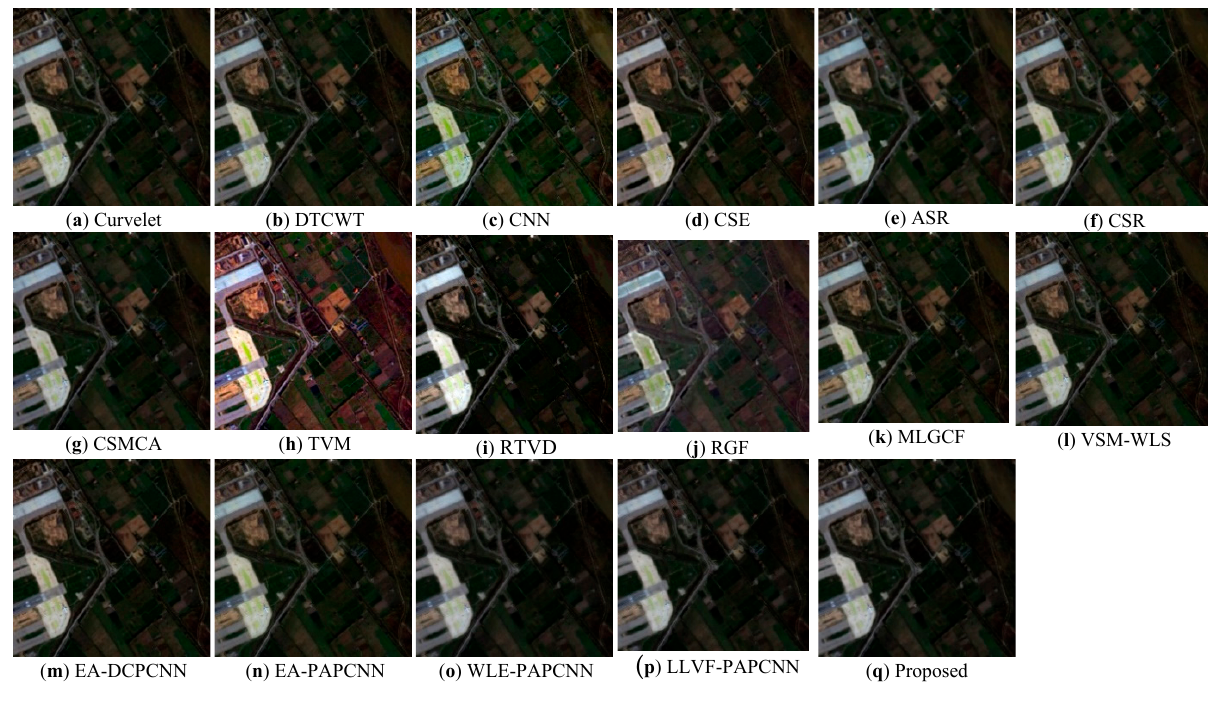
Figure 7. Fusion effect of SPOT-6 image.